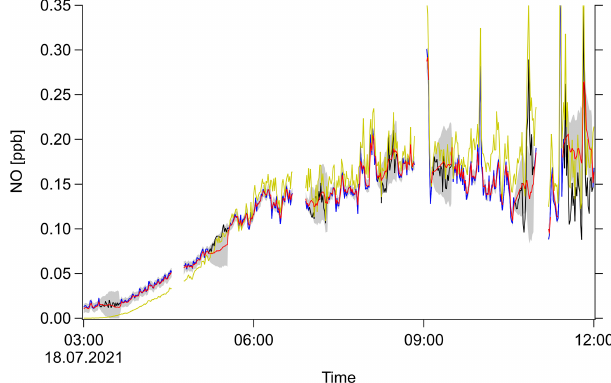
Figure 2. Example result of SMC used for interpolation. NO mix- ing ratio as a function of time (UTC) for an arbitrary day of the field campaign. Original measurement (black), measurement with arti- ficial gaps (blue), PSS calculation (yellow), SMC ensemble mean (red) and ± 1 σ interval (shaded gray region).